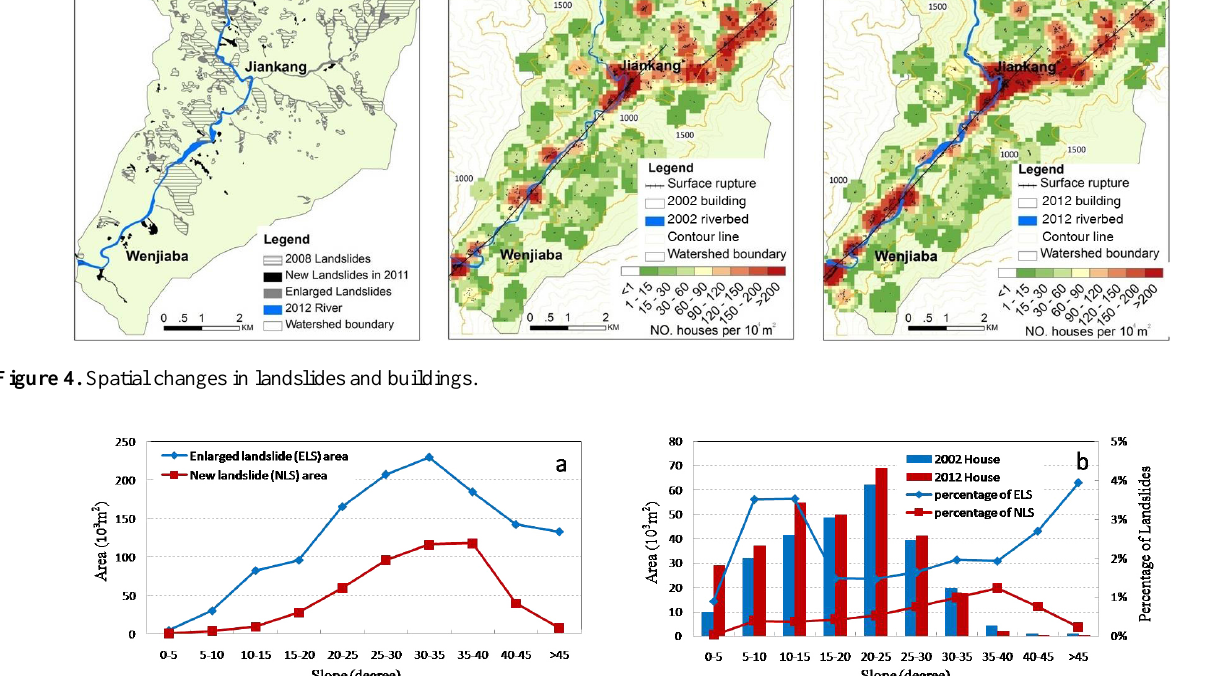
Figure 5. Distribution of new or enlarged landslides and buildings on different slope